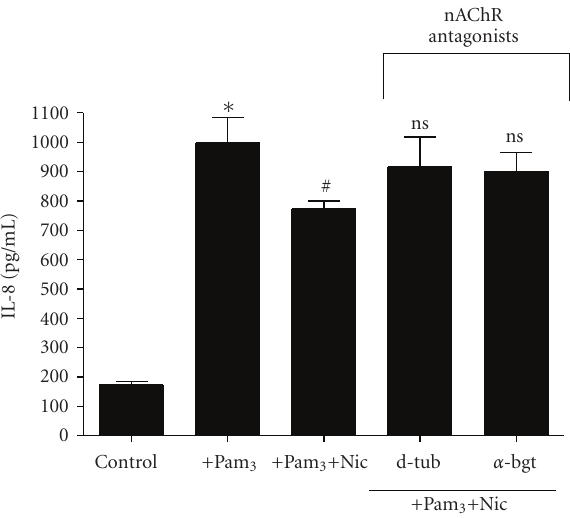
Figure 7: Inhibition of α 7-nAChR abrogates nicotine’s anti-TLR2 inhibitory e ff ect. CFTE29o- cells (1 × 10 5 /mL) were left untreated or treated d-tubocurarine (d-tub, 100 μ M) or α -bungarotoxin ( α -bgt, 1 μ M) for 16 h. Nicotine was added as indicated at 10 μ M for 1 hour. Following this, some samples were stimulated with Pam 3 (1 μ g/mL, 24 hours) and levels of IL-8 in supernatants were measured by ELISA ( ∗ and # P ≤ . 05, ∗ versus control, # or ns versus Pam 3 ). Assays were performed in triplicate ( n =